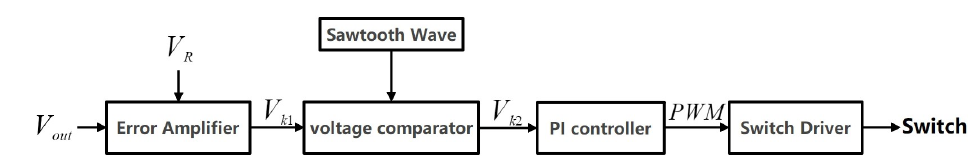
Figure 6. Control design of duty ratio adjustment